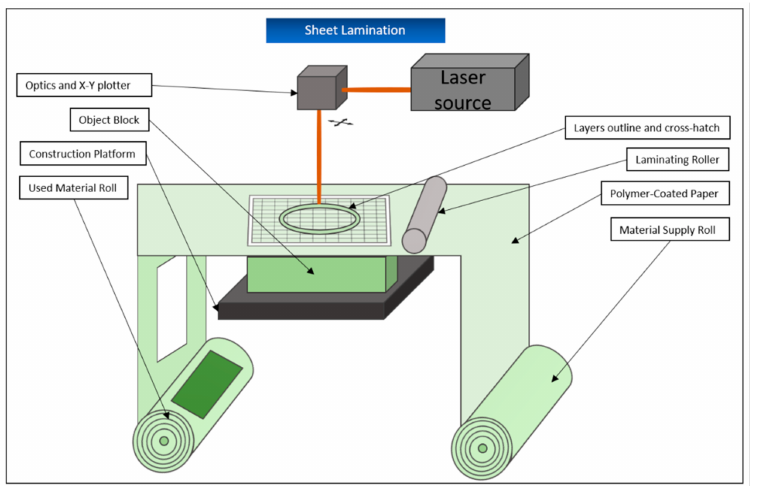
Figure 15. Schematic representation of the sheet lamination. The layers of the intended object are cut out of a continuously running roll of material under usage of a laser source and connected via a laminating